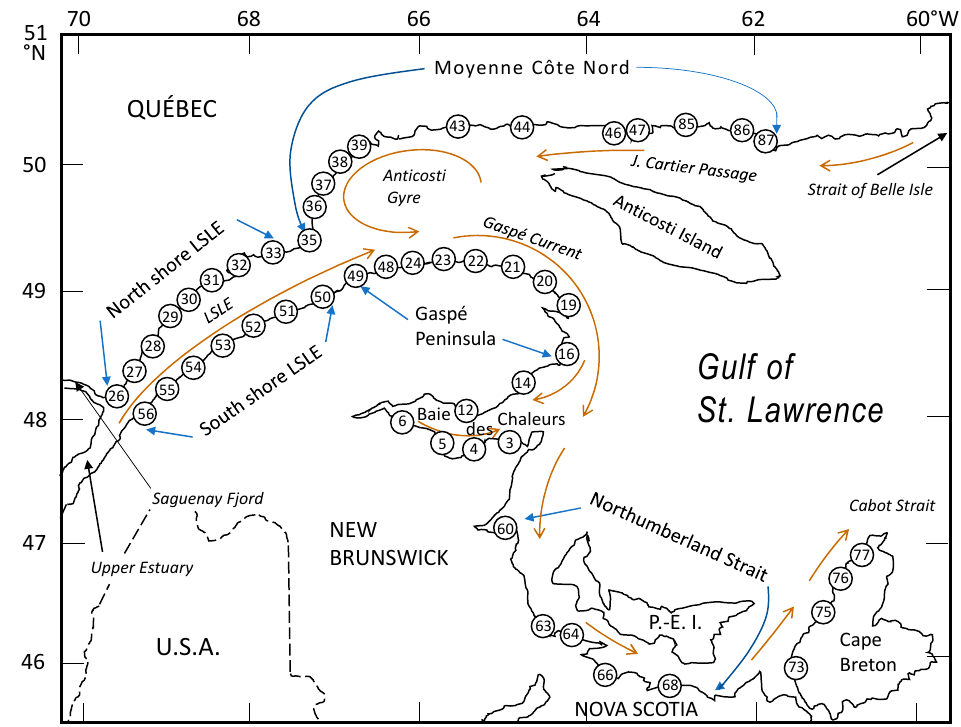
Figure 1. Location of the sampling sites and hydro-ecological regions. LSLE: Lower St. Lawrence Estuary. P.-E.I. Prince Edward Island. Brown arrows indicate main surface water circulation.